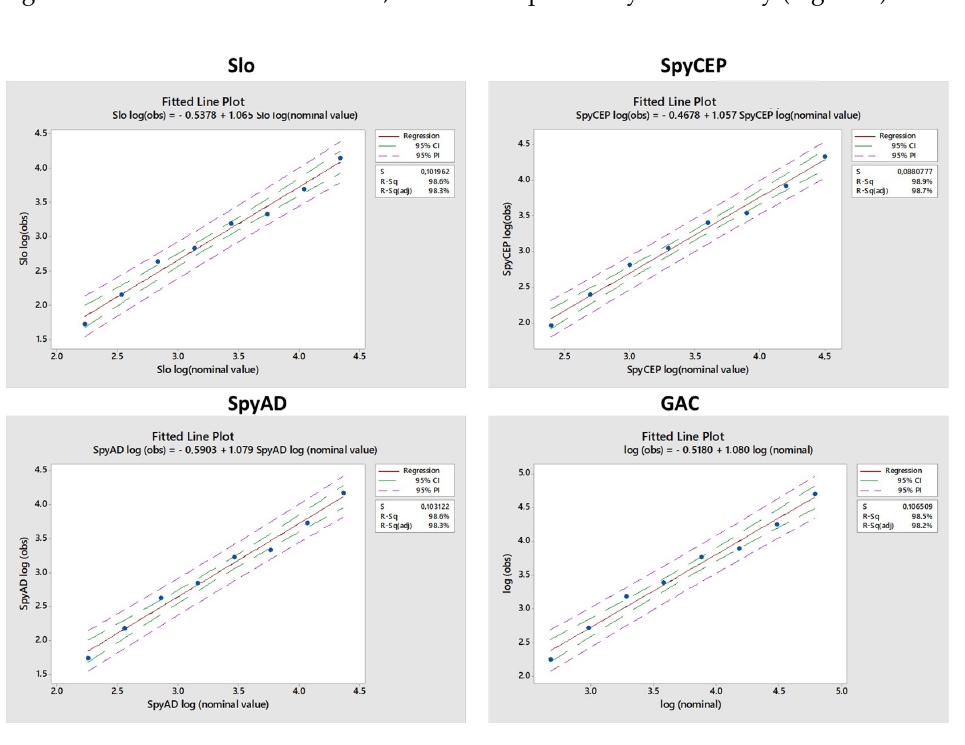
Figure 3. Linearity assessment . A single sample was independently diluted from neat to 1:128 and tested in the assay as separate samples. Correlation between observed IgG titres (log 10